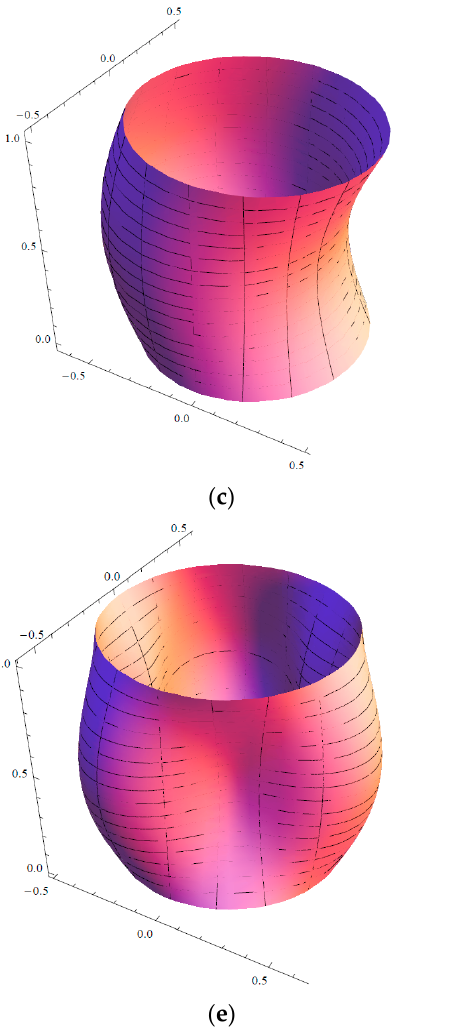
Figure 12. Mode shapes of the simply supported SWNT of Table 1 with chirality indices (𝑛 = 5,𝑚 = 5) and aspect ratio 𝐿/𝑅 = 10 : ( a ) Radial breathing mode (𝑞 = 0,𝑠 = 0) ; ( b ) axisymmetric mode (𝑞 = 1,𝑠 = 0) ; ( c ) beam-like mode (𝑞 = 1,𝑠 = 1) ; ( d ) shell-like mode (𝑞 = 1,𝑠 = 2) ; ( e ) shell-like mode (𝑞 = 1,𝑠 = 3) ; and ( f ) shell-like mode (𝑞 = 1,𝑠 = 4) .